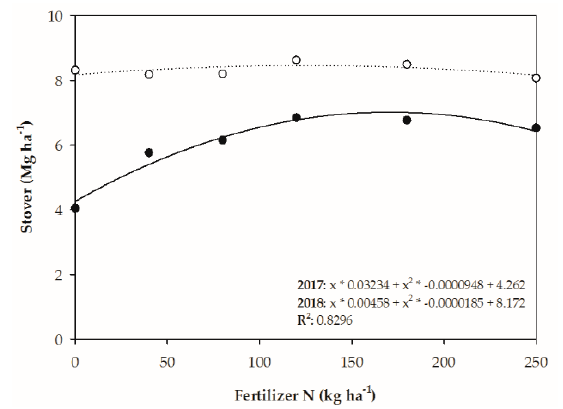
Figure 3. ( a ) response of grain yield and ( b ) grain N to fertilizer nitrogen (N) rate for second-year maize in 2017 and 2018.